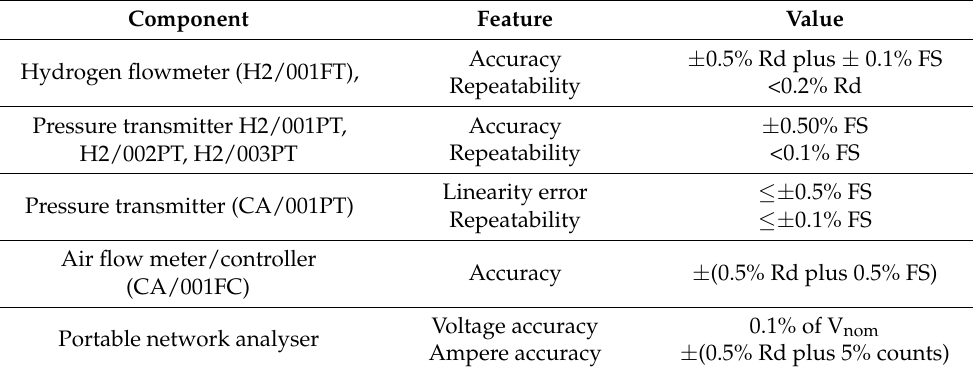
Table 6. Main metrological characteristics of the instrumentation.